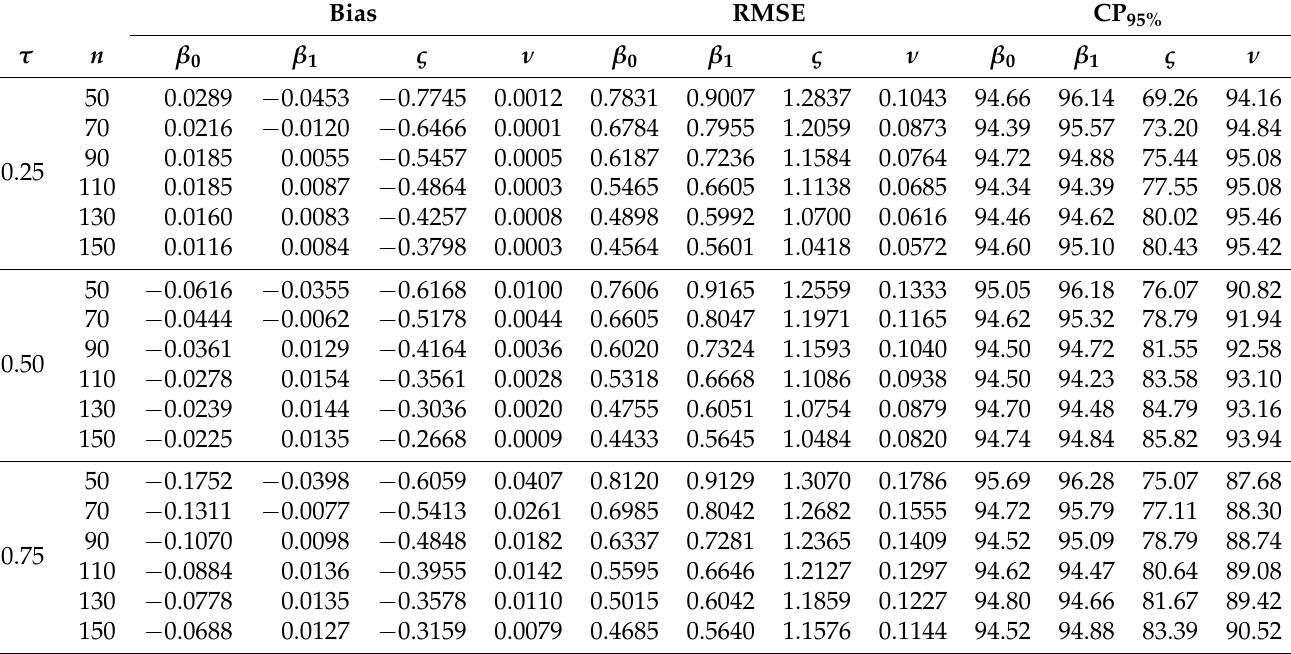
Table 8. Empirical RMSE, bias, and 95% CP (true values: β 0 = 0.50, β 1 = 0.50, ς = 2.00, and ν = 0.50) of the ML estimator for the indicated parameter with simulated